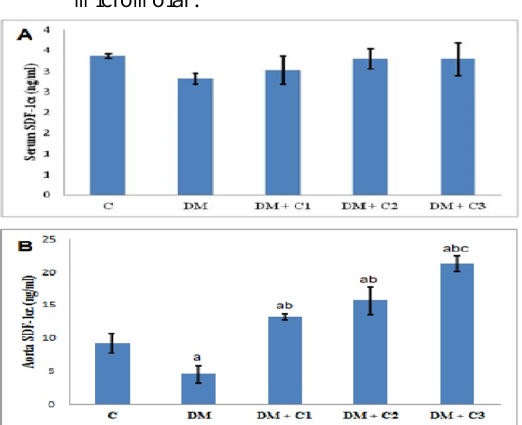
Figure 3. The serum NO level in each experimental groups. Values are presented as mean ± SD; a P < 0.05 in comparison with control (C) group; b P < 0.05 in comparison with diabetes mellitus (DM) group; c P < 0.05 in comparison with first dose catechin administered (DM + C1) group; d P < 0.05 in comparison with second dose catechin administered (DM + C2) group. DM + C3: diabetes mellitus group received third dose of catechin;  M: micromolar.